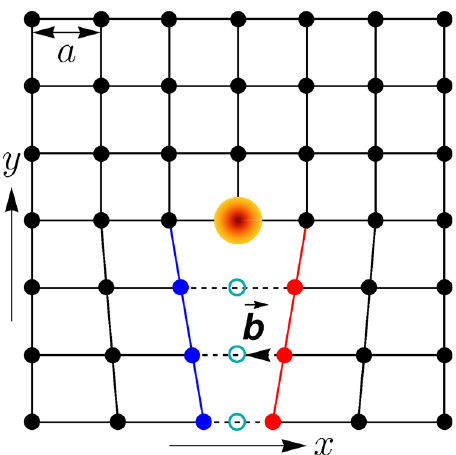
Fig. 1 Construction of a single edge dislocation. Volterra cut-and-glue procedure on a square lattice, implemented by removing a line of atoms (open cyan circles), ending at the center or core of the dislocation (orange circle) and subsequently reconnecting (represented by the dashed lines) the sites (red and blue dots) living on the edges (red and blue lines) across it. The corresponding Burgers vector is b = a e x .